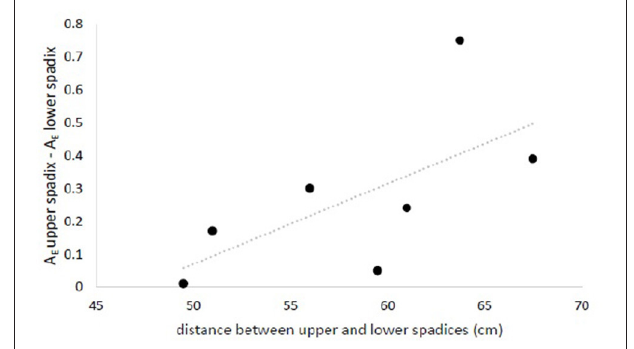
FIGURE 11 | Difference in allelic richness between seeds collected from upper- and lower-most spadices (rarified to the smallest sample size) increased with increasing distance between inflorescences. n seed seeds/spadix) x (2 spadices/maternal shoot) x (7 maternal shoots). Data is available from the authors upon FIGURE 10 | Number of particles remaining in the water column with distance from the release point x rel / h 0 for 10,000 filamentous particles released in a = canopy ( H / h 5, u 0.01 m/s, L v 1 cm, a 2 m − 1 , C D 1.95, = = = = ∗ = h 1 m) with varied release heights ( z rel / h 1, 0.75, 0.25) and a reflecting = = surface boundary. Particles were evaluated at two locations ( x / h 0.01,0.02) = chosen to occur before the location of first deposition of particles from the lower release points and 10 points spaced equally in log space, ( x / h 0.05, = 0.13, 0.32, 0.80, 2.0, 5.0, 13, 32, 80, 200). A line illustrating a power law with decay constant 1/2 is plotted for reference (black dashed line). −